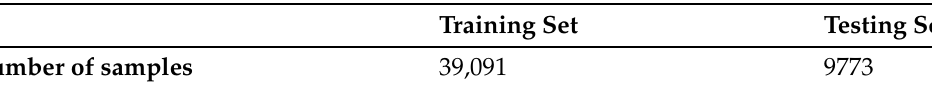
Table 2. Number of training and testing